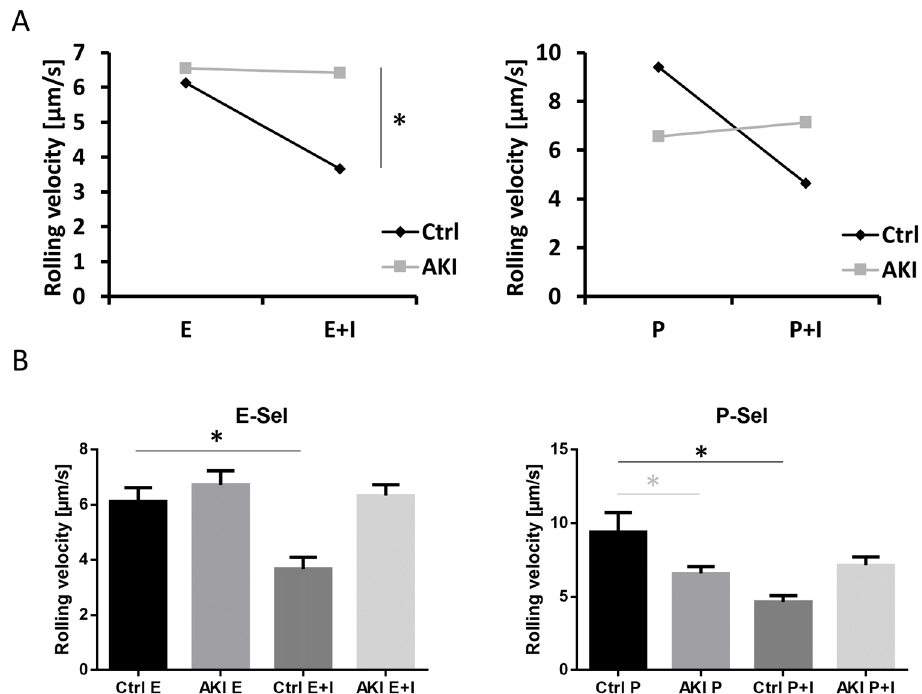
Figure 3. Acute kidney injury impairs leukocyte slow rolling. ( A ) Slow leukocyte rolling was assessed using whole blood perfused into microfluidic chamber devices. ( B ) Bar-graph representation with error bars of ( A ): T -test was performed for analysis of integrin response for each condition (shown as black bar and asterisk). Inter-group variations were tested using ANOVA (light gray bar and asterisk) (n ≥ 3 individual patients; * p < 0.05; mean ± SEM).